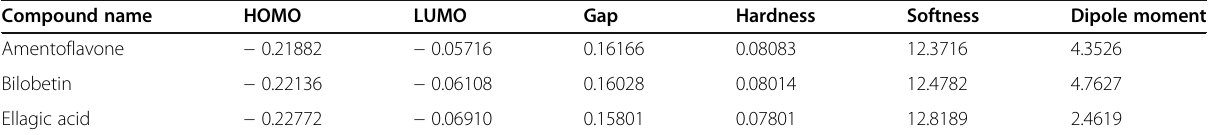
Table 8 Result of DFT calculation. The unit of HOMO, LUMO, gap, hardness, and softness are in Hartree and the unit of dipole moment is in